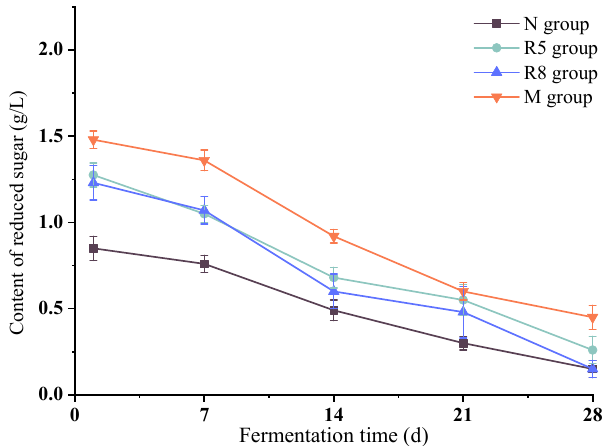
Figure 3. Changes in reduced sugar content in pickles during fermentation.